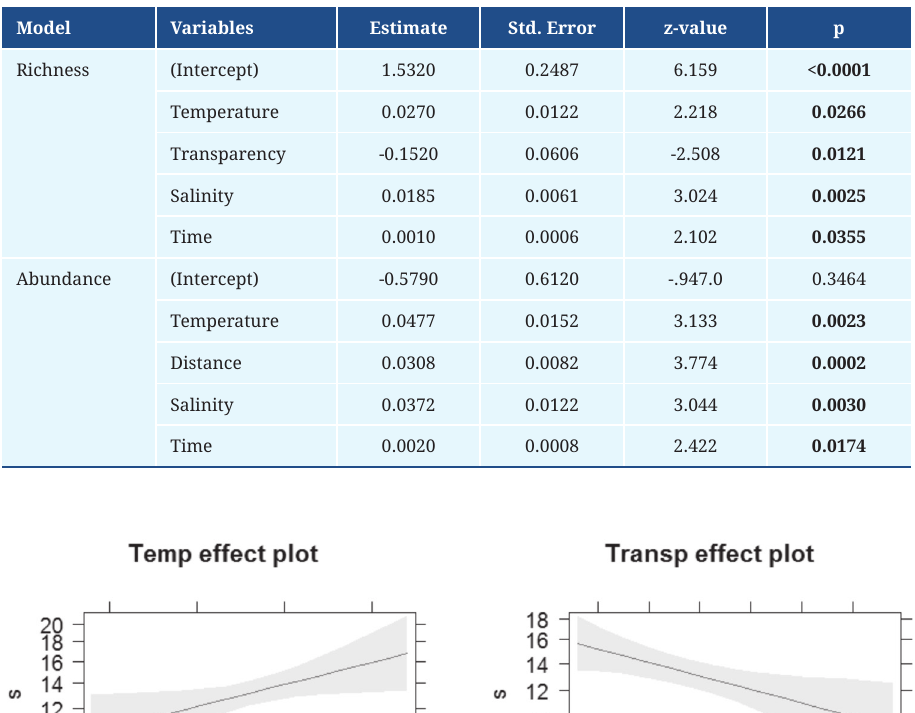
FIGURE 5 | Richness (S) relationship with the environmental variables that formed the most parsimonious GLM. Line represents the modeled values, and a gray area corresponds to the standard deviation. Temp = temperature; Transp = transparency; Sal = salinity; Time = succession of days from beginning to end of the sampling surveys (see Material and Methods section for